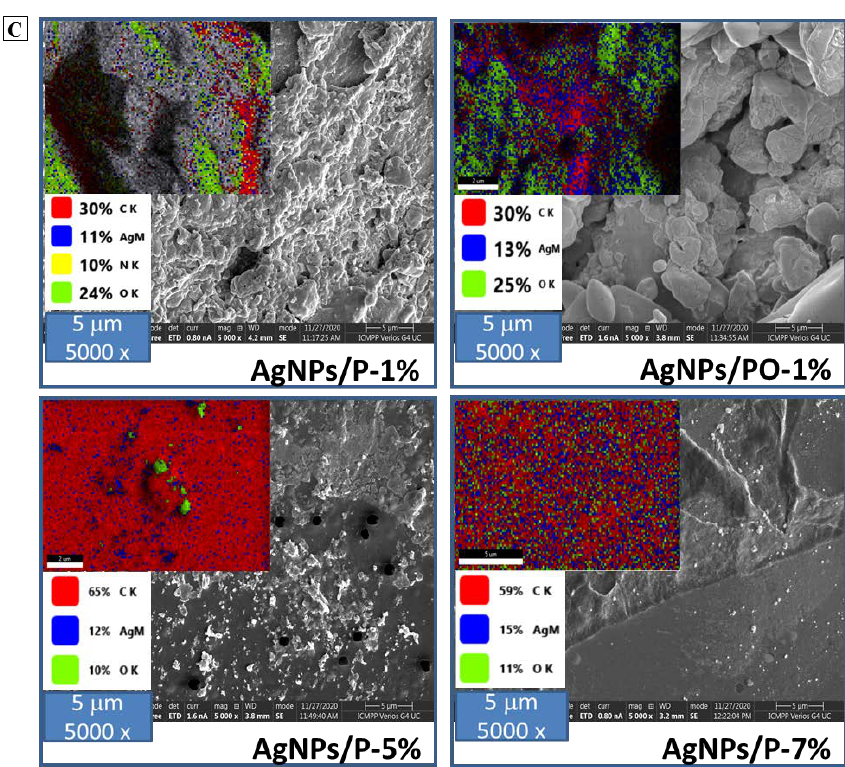
Figure 1. Selective oxidation of C6 primary OH groups of pullulan to carboxylate moieties by TEMPO/sodium hypo- chlorite/sodium bromide system, in water at pH 10 ( A ); simplified scheme of the silver nanoparticles generation in the presence of pullulan/ oxidized pullulan ( B ) and SEM images of silver nanoparticles prepared by using different concen- tration of pullulan or oxidized pullulan and AgNO 3 ( C ).